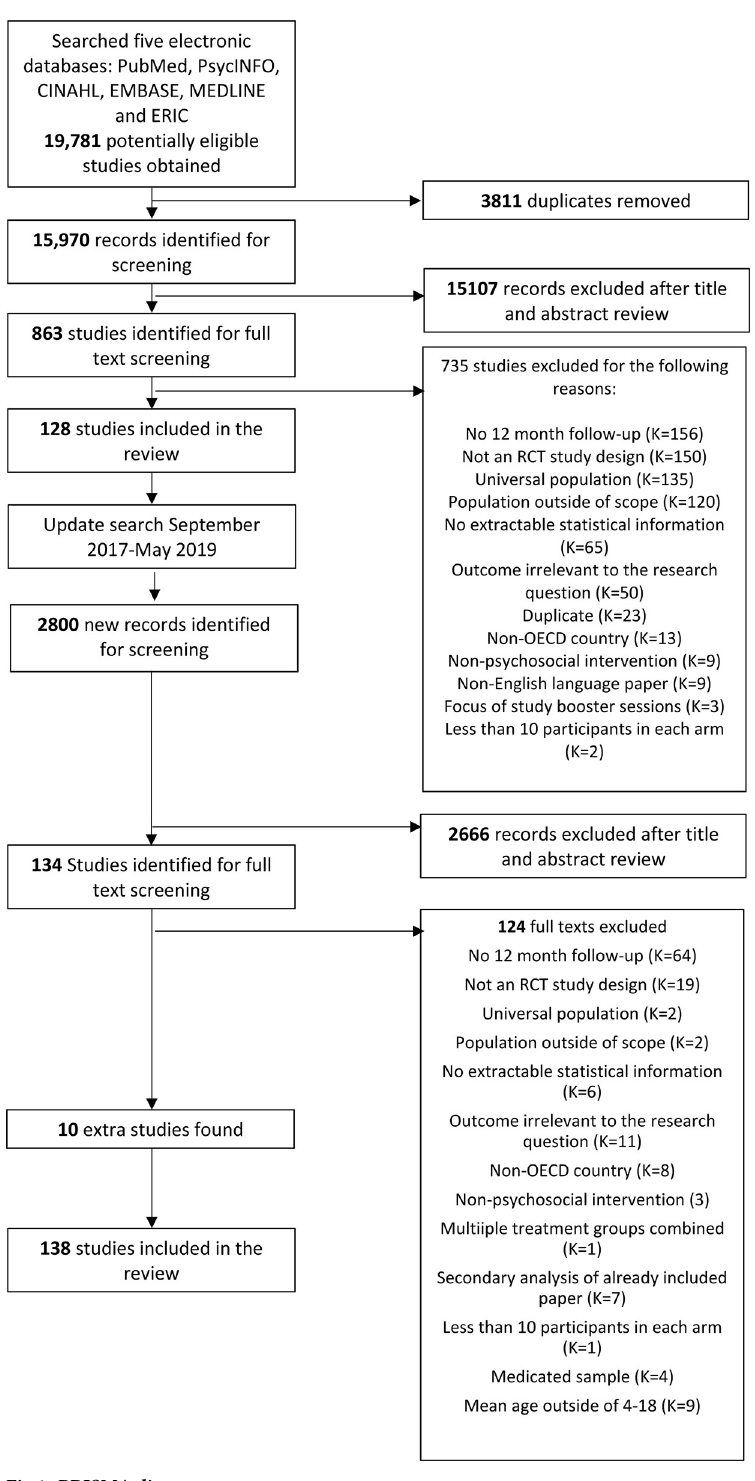
Fig 1. PRISMA diagram.